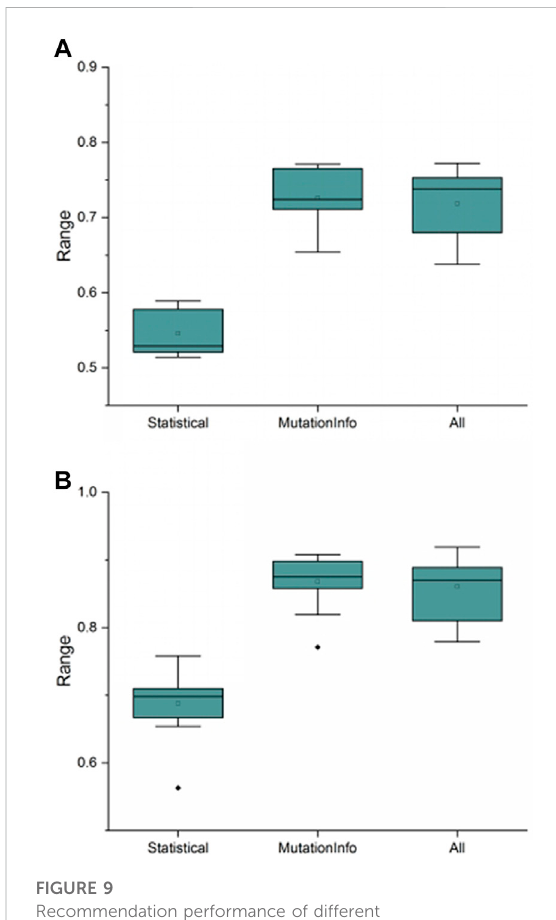
FIGURE 9 Recommendation performance of different recommendation models constructed with different meta- features. (A) and (B) show the comparison results of different meta-features on f-measure and AUC performance evaluation metrics, respectively, where “ Statistical ” denotes the traditional meta-features, “ MutationInfo ” denotes the variational signature-basedmeta-features,and “ All ” denotesthecombination of two meta-features. The ordinate indicates the values of the corresponding performance evaluation metrics.